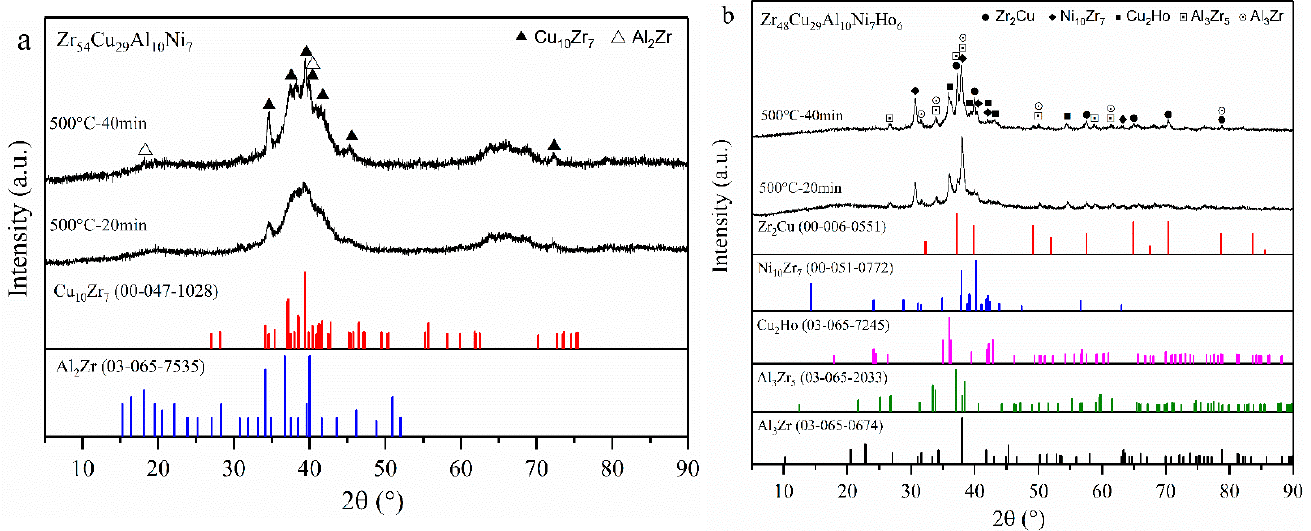
Figure 8. XRD patterns of ( a ) Zr54 BMG and ( b ) Zr48Ho6 BMG annealed at 500 °C for various times.